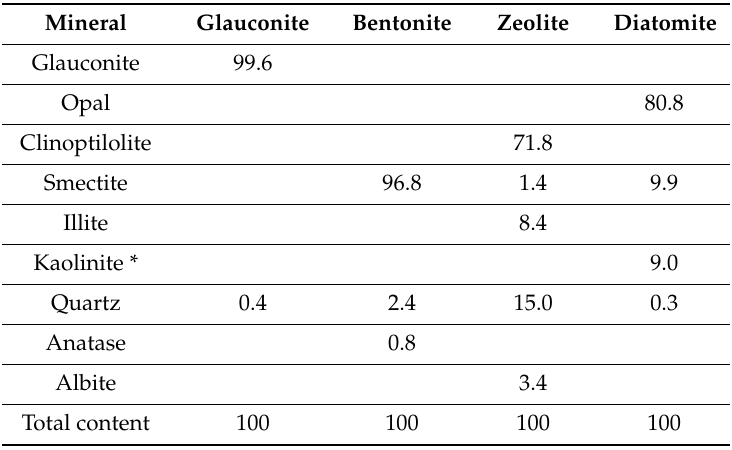
Table 2. Mineral composition of the examined samples,